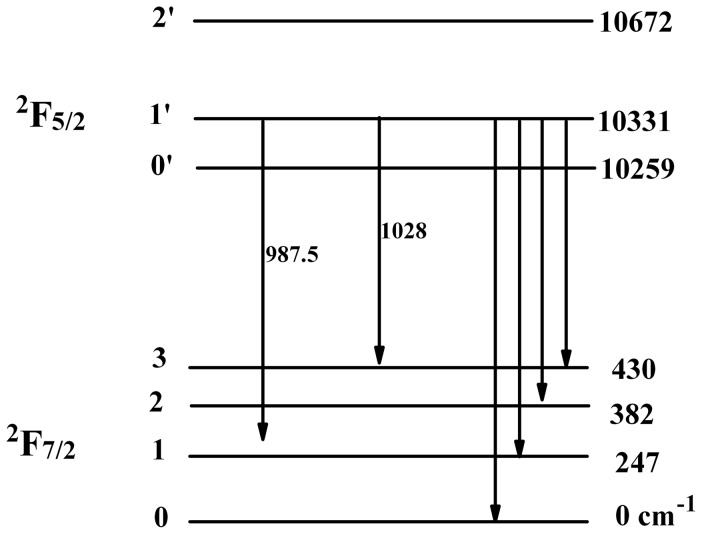
Stark energy-level diagram of the 2F5/2 and 2F7/2 manifold of Yb3+ in KBaGd(MoO4)3 crystal.